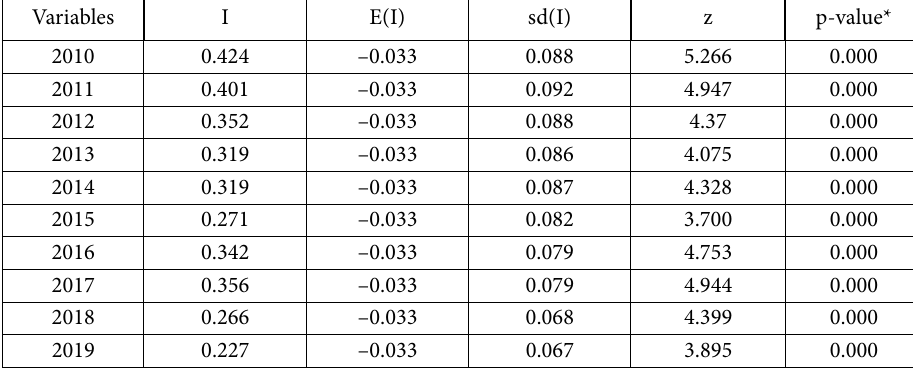
Table 4. Global Moran’s Index of the level of